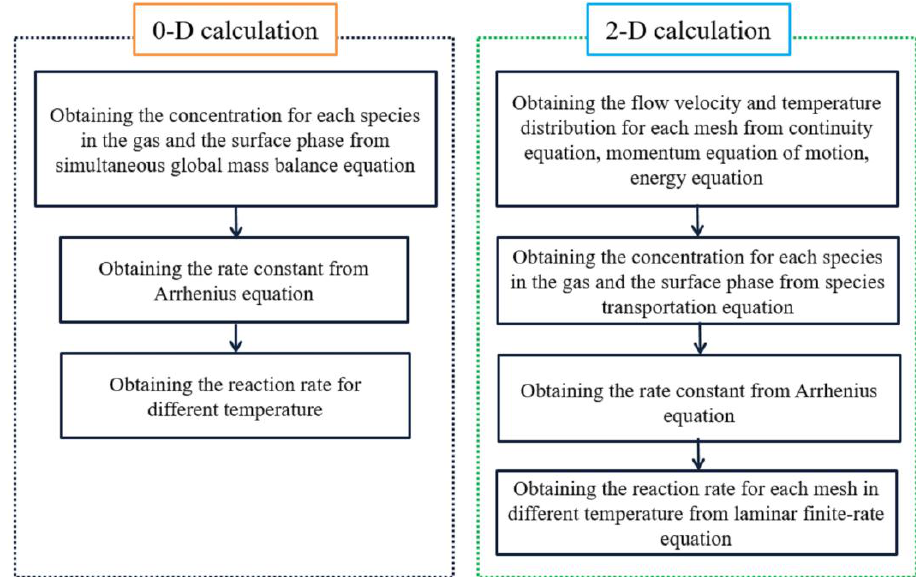
Figure 2. Schematic procedure for the 0-D and 2-D numerical analysis.